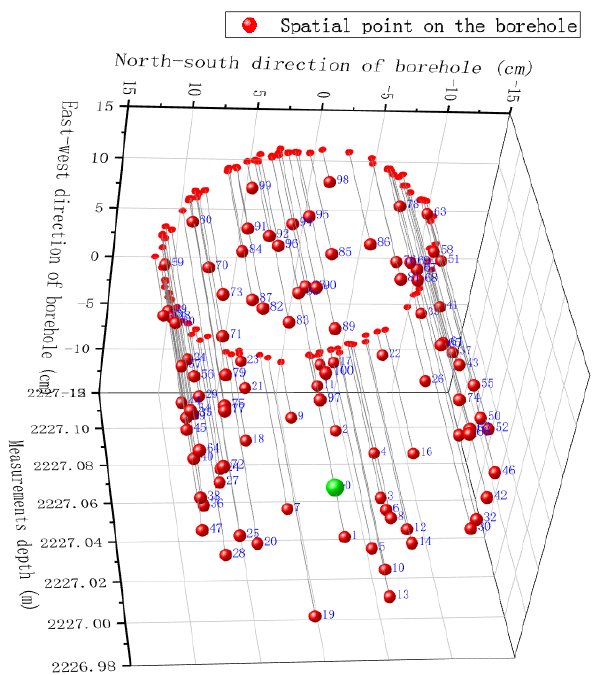
Figure 9. Distance between the insertion point and the point inside the window U.